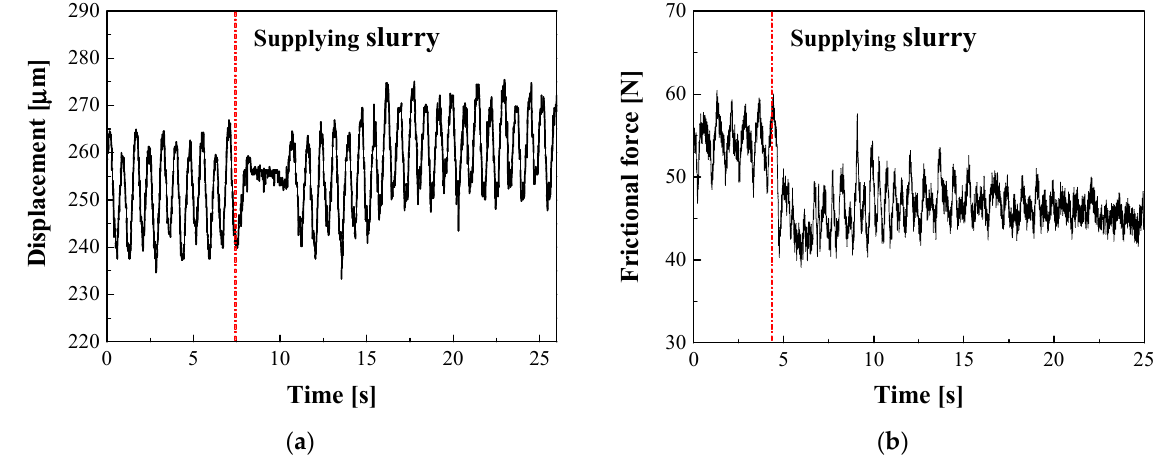
Figure 9. ( a ) Changes in displacement of the head upon supplying slurry ( d g = 0.1); ( b ) changes in frictional force upon supplying slurry ( d g = 0.2).